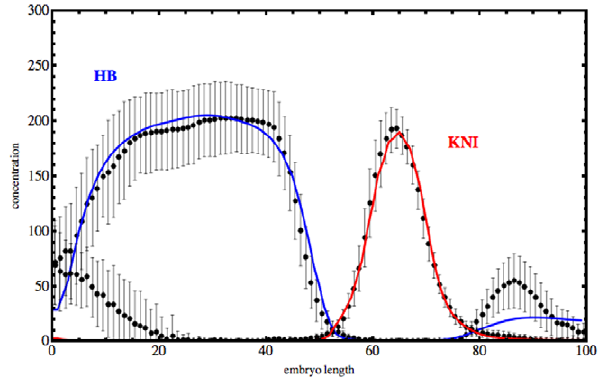
Figure 9. The dots with error bars are the mean experimental profiles of the proteins HB and KNI at cleavage cycle 14, taken along the antero-posterior axis of the embryo, for several Drosophila embryos. The mean distribution of the concentration of proteins has been calculated from the data of 954 embryos, taken from the FlyEx database. The embryo length has been scaled from 0 to 100 , and the units in the vertical axis are proportional to protein concentration. The continuous curves show the predictions of the model of production of proteins HB and KNI. The model equations have been obtained with the software package GeneticNetworks